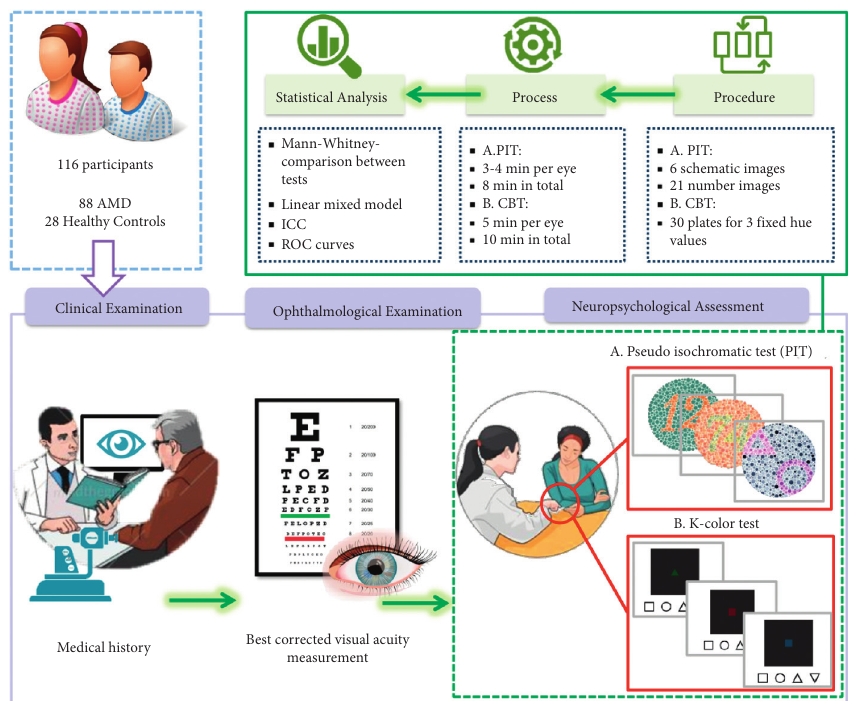
Figure 1: Testing procedure including a comprehensive medical history, best corrected visual acuity, and color testing. (A) Pseudoi- sochromatic tests, Ishihara, and H-R-R. (B) The K -color test with plates composed of a black square with white boundaries and a colored target in the center. Identification of the colored targets was made by selecting one shape from a choice of four that corresponds to the target in the examined plate. Statistical analysis was performed using IBM SPSS Statistics for Windows, version 26.0 (Armonk, NY: IBM Corp). ICC: intraclass correlation coefficient (95% confidence intervals); ROC curves: receiver-operating characteristic curves; CBT: color brightness test ( K -color